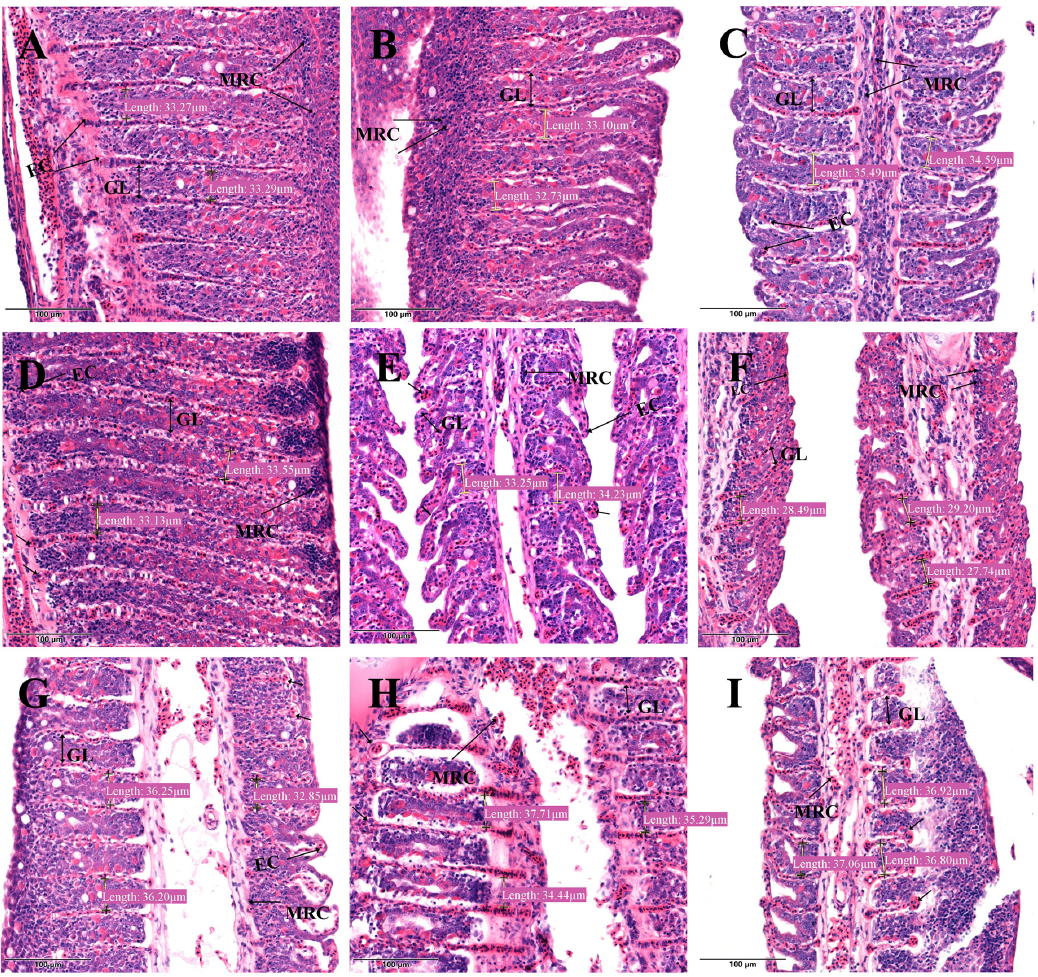
Figure 4. Representative H&E-stained sections showed changes in gill structure in pearl gentian grouper following 0, 48, and 72 h of exposure to various concentrations of nitrite: ( A ) 0 mg/L-0 h, ( B ) 0 mg/L-48 h, ( C ) 5 mg/L-48 h, ( D ) 10 mg/L-48 h, ( E ) 20 mg/L-48 h, ( F ) 0 mg/L-72 h, ( G ) 5 mg/L- 72 h, ( H ) 10 mg/L-72 h, and ( I ) 20 mg/L-72 h. Bars = 100 µ m. Gill lamella (GL), epithelial cell (EC); mitochondrial-rich cell (MRC), and epithelial cell hyperplasia ( ↑ ).